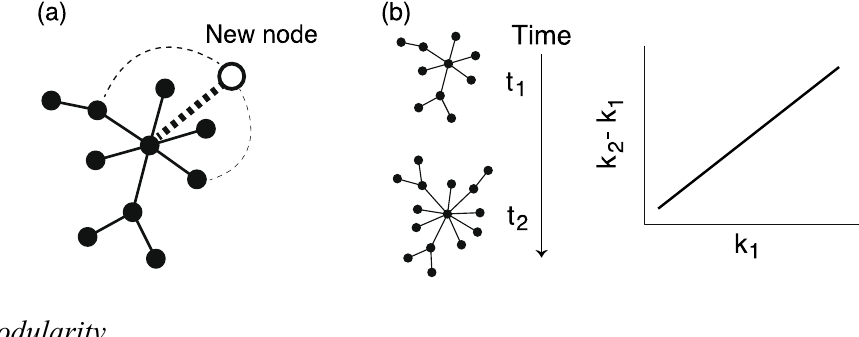
– k , where k and k are the 2 1 1 2 and t , 1 2